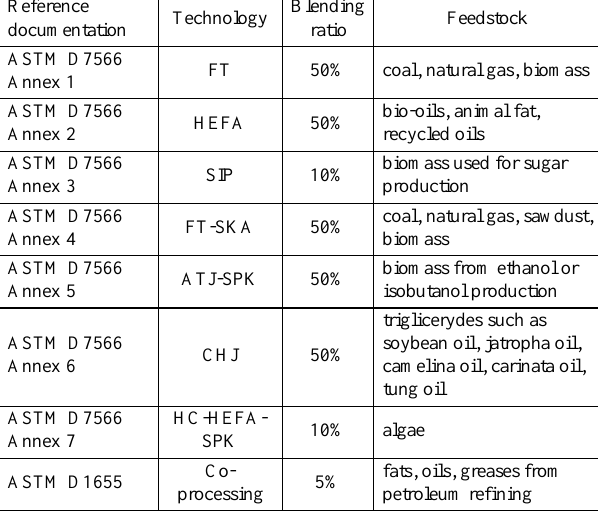
Table 1. SAF conversion processes